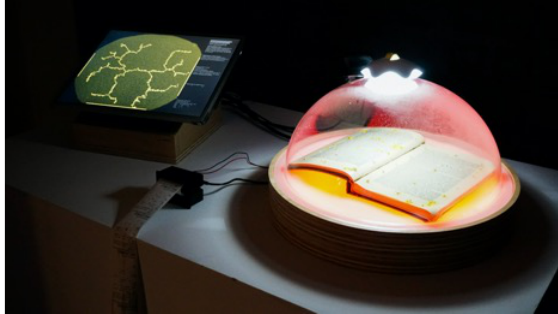
Figure 3 | Digital fungus in Degenerative Cultures , Portugal edition, Cesar & Lois, 2019